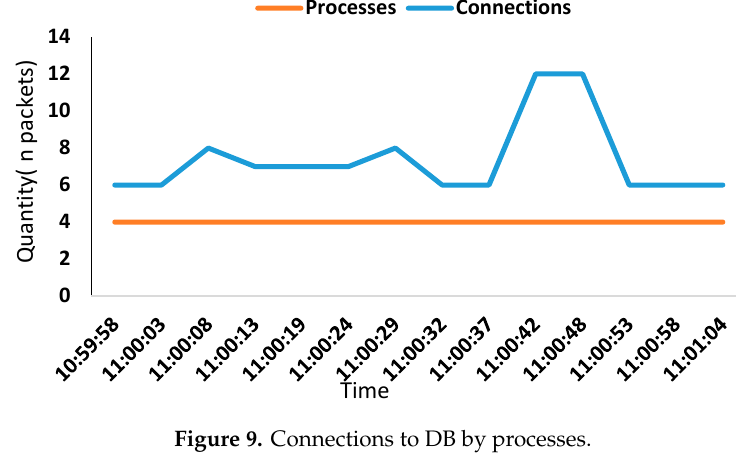
Figure 9. Connections to DB by processes.